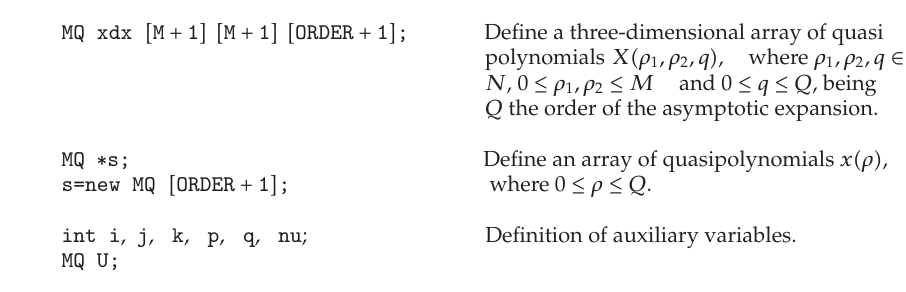
Algorithm 3: Implementation of the algorithm. Steps (cid:3) 1 (cid:4) and (cid:3) 2 (cid:4) .